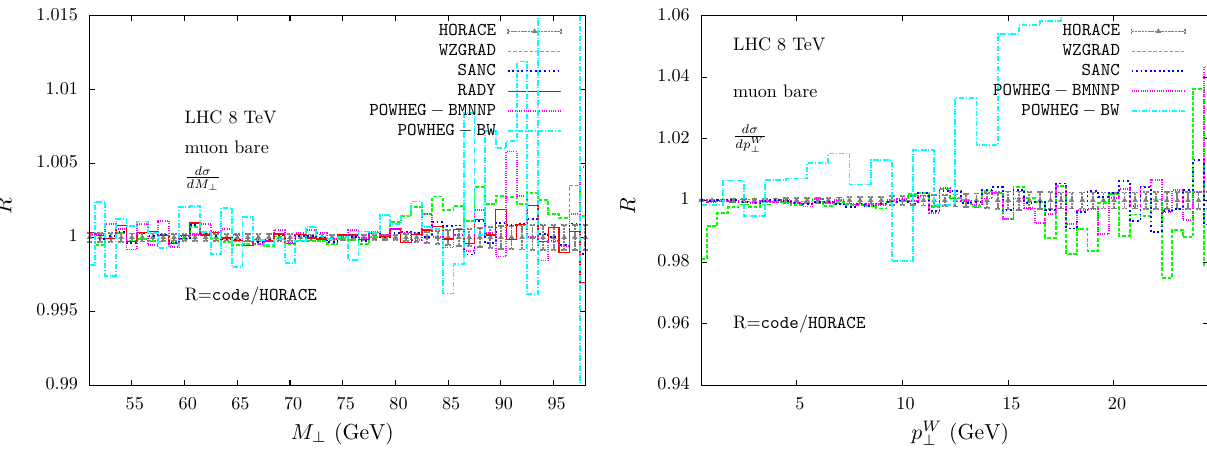
Fig. 3 Tuned comparison of the lepton-pair transverse mass and transverse momentum distributions in pp → W − → μ − ν μ + X at the 8 TeV LHC with ATLAS/CMS cuts in the bare setup, including NLO EW